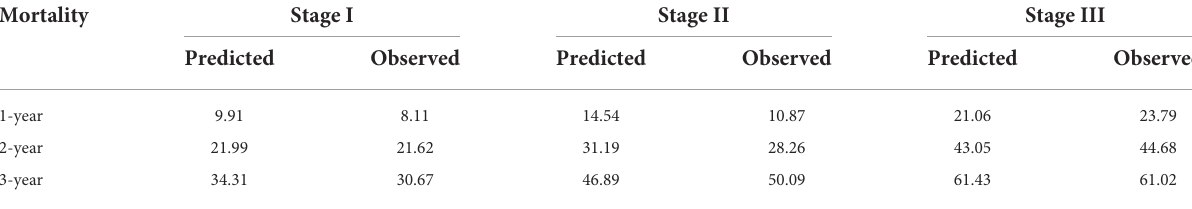
TABLE 5 Predicted and observed mortality of CPB stage in the derivation cohort.